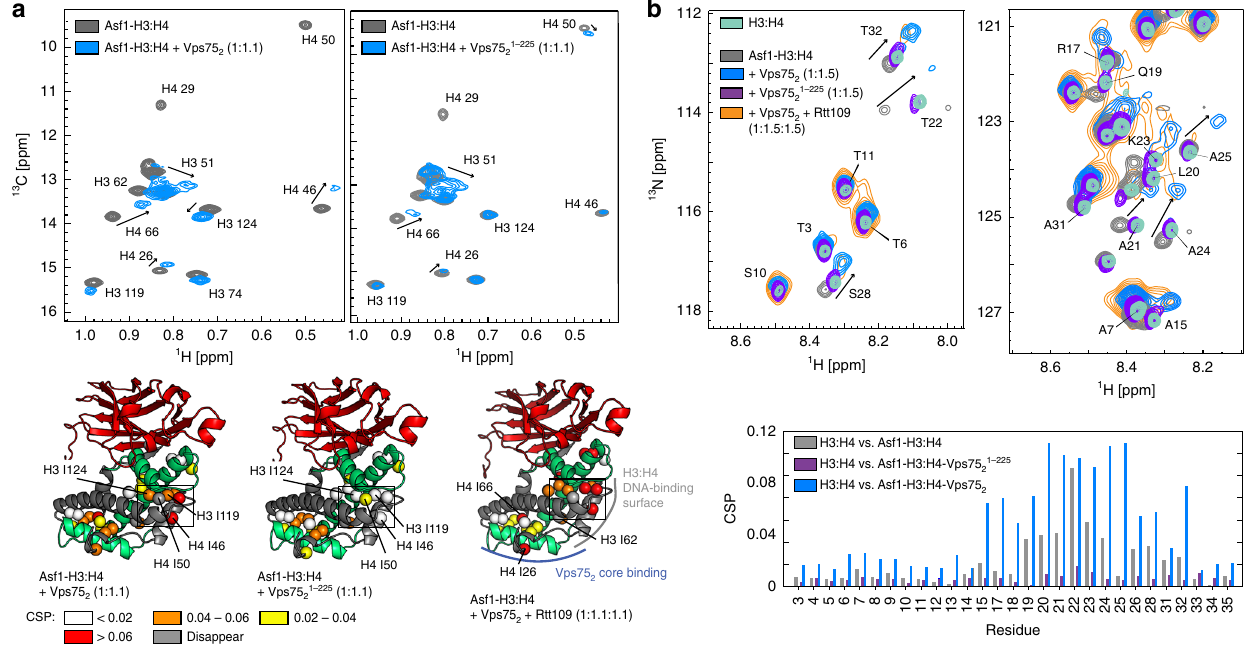
Fig. 4 The Vps75 CTAD interacts with both the H3 core and tail. a Comparison of the 1 H- 13 C HMQC spectra of ILV methyl-labeled H3:H4 in the Asf1 – H3: H4 complex and upon addition of either 1.1 equivalents of Vps75 2 (left) or Vps75 2 1 – 225 (right). The corresponding CSPs mapped on the Asf1 – H3: H4 structure (PDB entry 2hue) are shown in the bottom-left and bottom-middle panel, respectively. The CSPs obtained after addition of 1.1 equivalents of Rtt109 – Vps75 2 to Asf1 – H3:H4 (bottom-right panel) are very similar to those obtained with Vps75 2 and demonstrate that the Vps75 CTAD interacts with the DNA-binding surface of H3:H4 in both Asf1 – H3:H4 – Vps75 2 and Asf1 – H3:H4 – Rtt109 – Vps75 2 . b Top, 1 H- 15 N HSQC spectra of H3 in the H3:H4 dimer, in the Asf1 – H3:H4 complex and upon further addition of Vps75 2 , Vps75 2 1 – 225 or Rtt109 – Vps75 2 . Bottom, the corresponding CSPs plot. In Asf1 – H3:H4, the H3 tail interacts with Asf1, as reported by Lercher et al. 34 . In the presence of Vps75 2 1 – 225 , the H3 tail is released from Asf1 and recovers the CSs of the H3:H4 dimer; in the presence of Vps75 2 , the H3 tail peaks move to new positions. The NMR experimental conditions were as in Fig. 1. Source data are provided